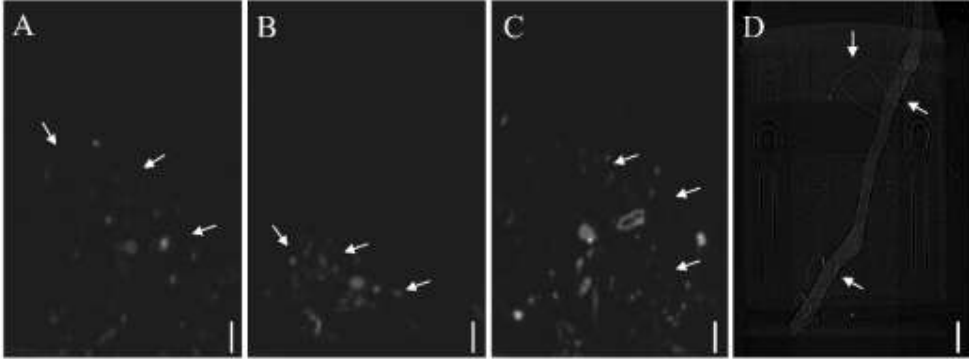
Figure 2. X-ray CT imaging of roots of poplar seedlings in different soil types. ( A ) Sand + ½ MS; ( B ) clay + ½ MS; ( C ) loam + ½ MS; ( D ) vermiculite + ½ MS. The scale is 1 cm. The white arrow represents the location of the X-ray CT imaging density.